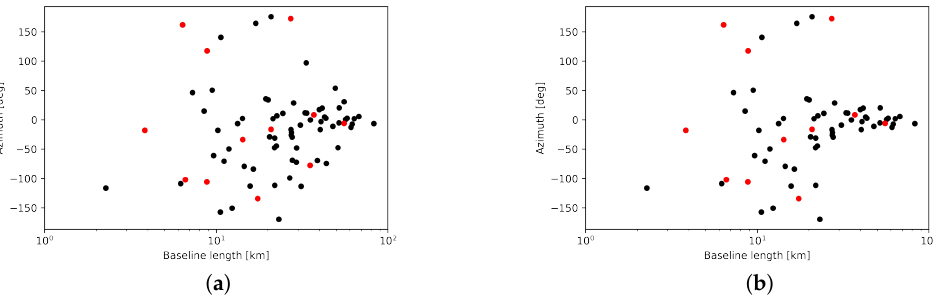
Figure 7. Baselines’ azimuths and lengths distribution for all combinations of remote stations for ( a ) L82655 and ( b ) L79324. Red dots denote original baselines, black dots denote additional